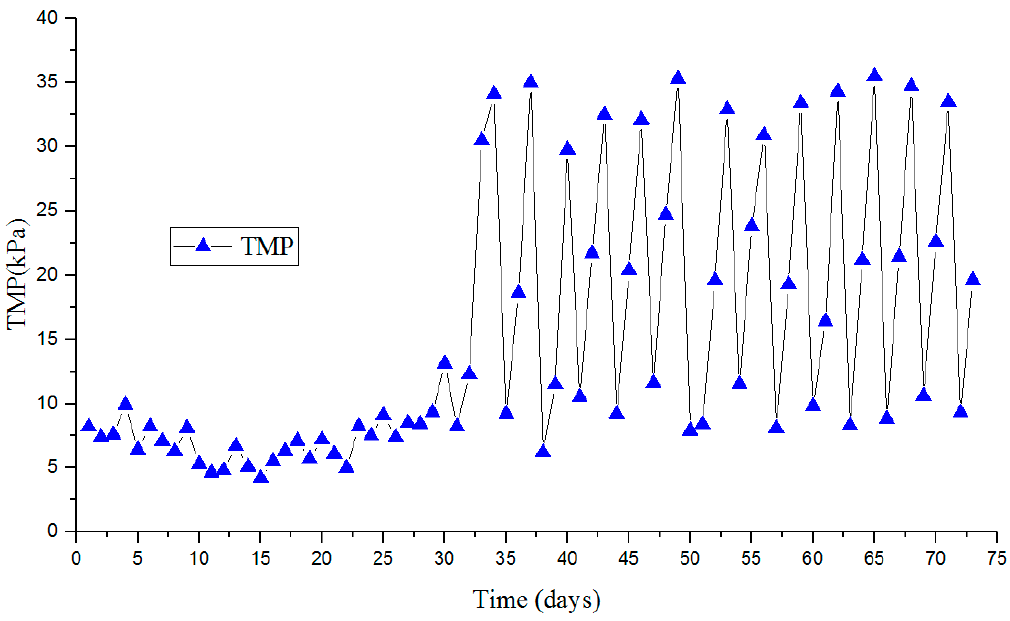
Figure 4. Trans-membrane pressure (TMP) changes during the study.